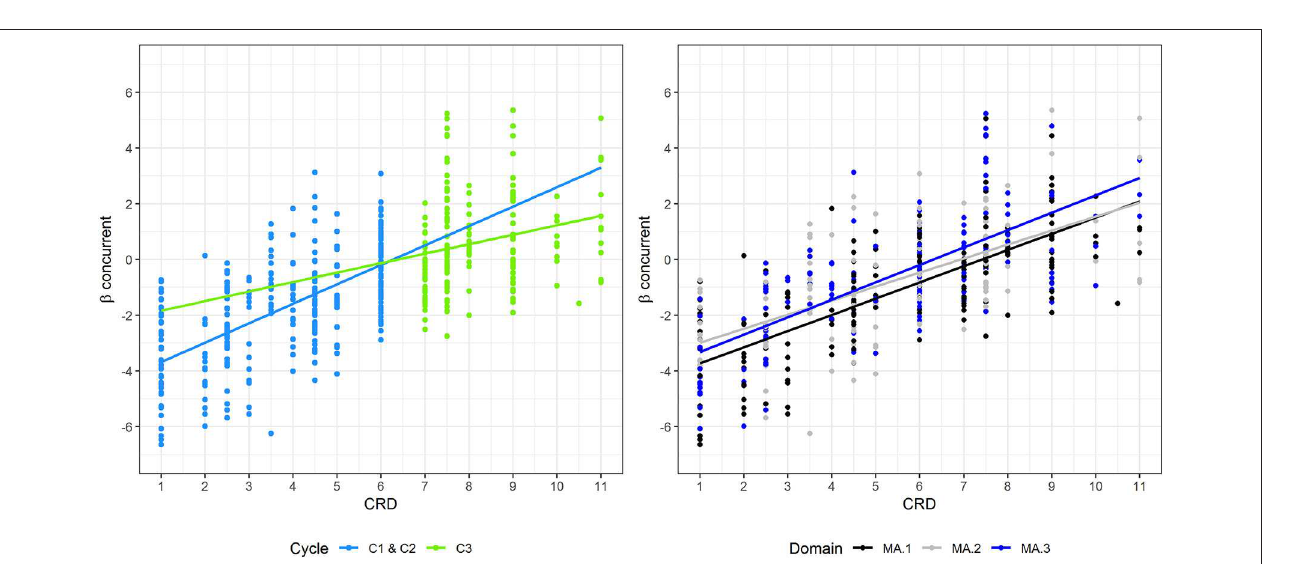
FIGURE 4 | Relationship between difficulty estimates and CRD and related regression lines per cycle (left) and per domain (right)